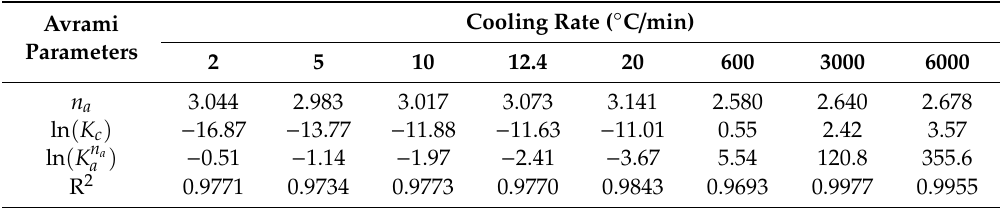
Table 1. Results of the linear fit of the Avrami plots of each individual cooling rate. All fits show good fitting accuracy with an R 2 value around